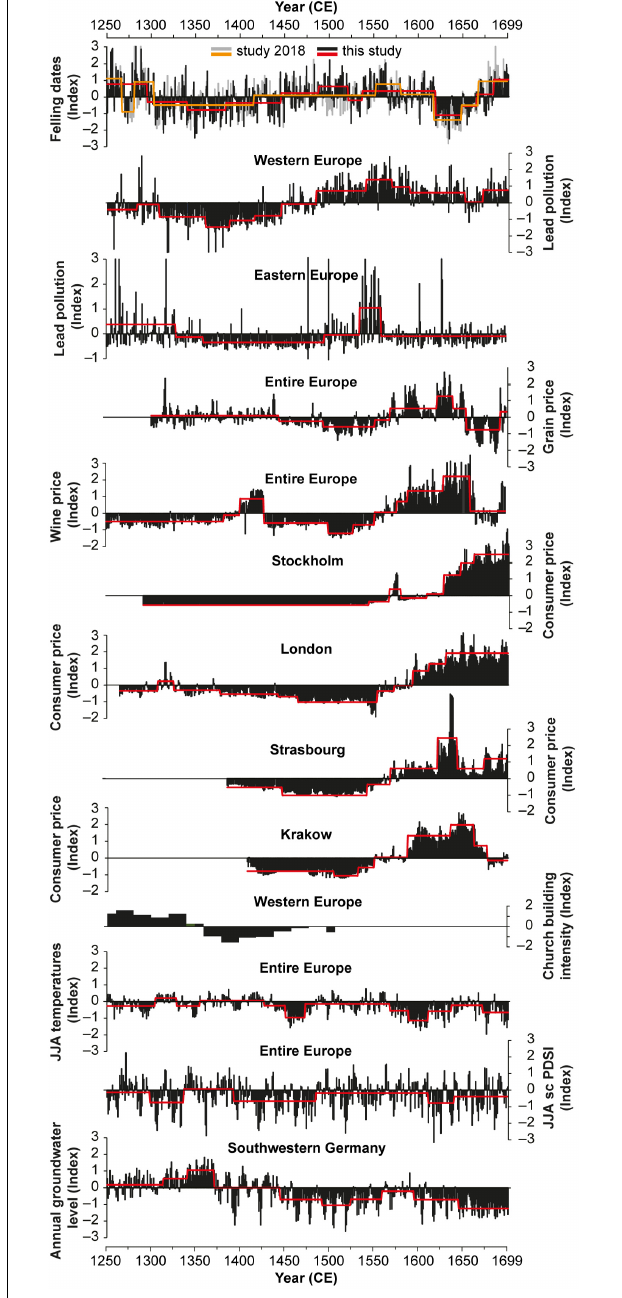
FIGURE 7 | Figure showing the new entire felling date dataset, and the one Ljungqvist et al. (2018) for comparison, together with other datasets indicating general societal well-being and prevailing climate conditions. All data is standardized to z -score values over the entire period and 300-year filtered values. The red lines show the significant regime shifts in the number of felling dates, using a 30-year cut-off length.